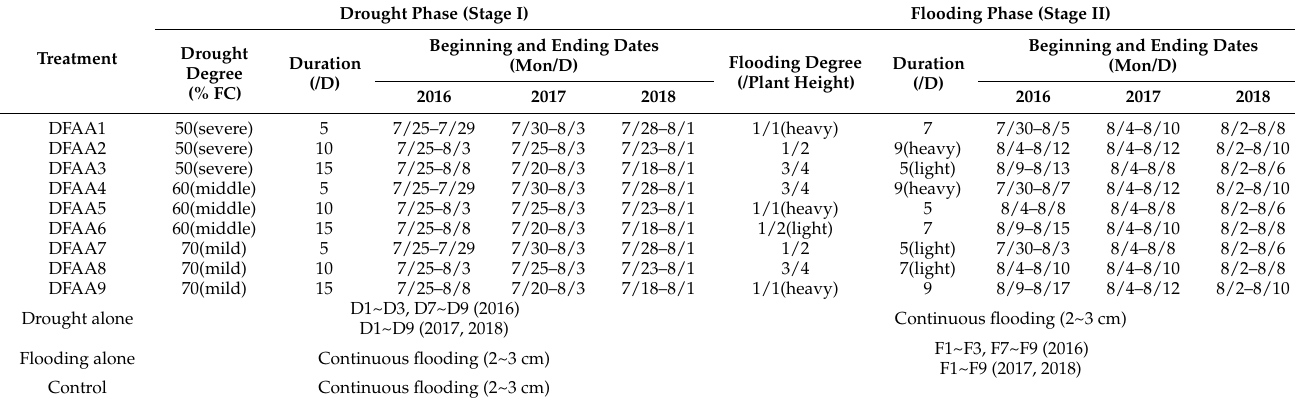
Table 1. Experimental water control design for rice jointing–booting stage in the years of